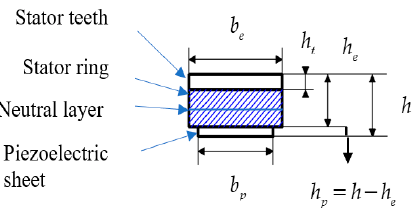
Figure 2. Schematic of piezoelectric composite structure.